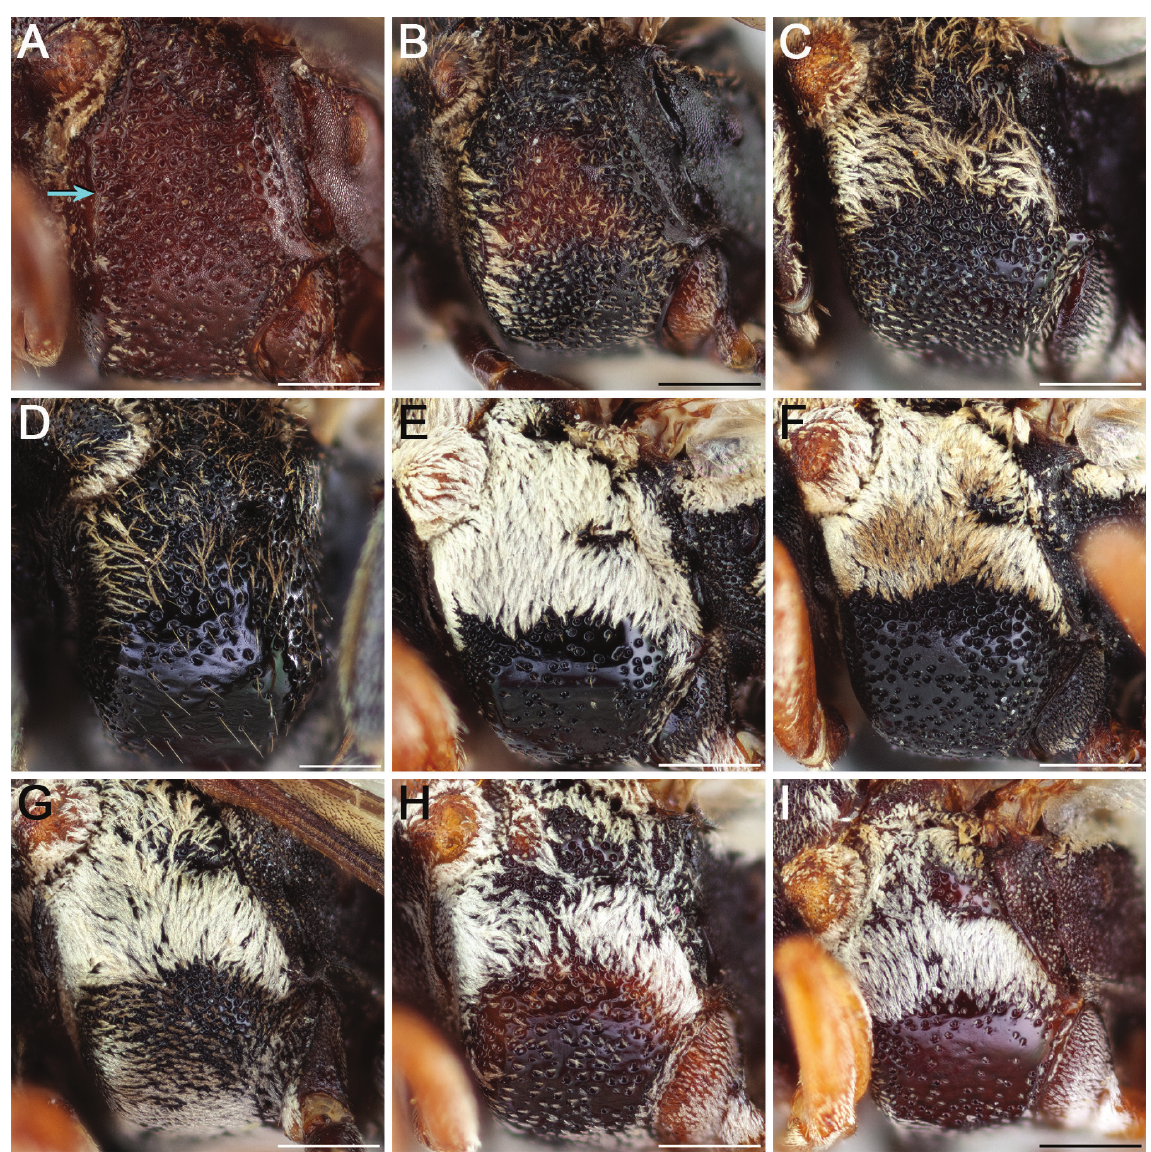
Fig. 5. Mesopleuron of female, lateral view. A . E. claripennis Friese, 1908, holotype (ZMB), blue arrow indicates carina delineating the anterior and lateral surfaces of the mesopleuron. B . E.